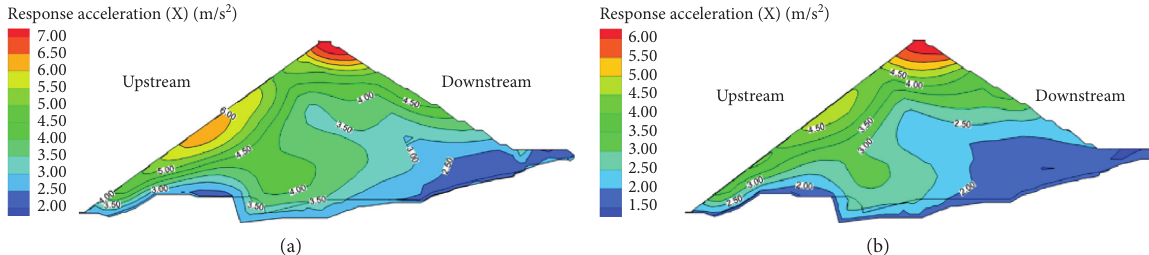
Figure 5: Distribution of response acceleration in the up-downstream direction (m/s 2 ). (a) The distribution of response acceleration based on UHS. (b) The distribution of response acceleration based on site-related response spectrum using scenario earthquake